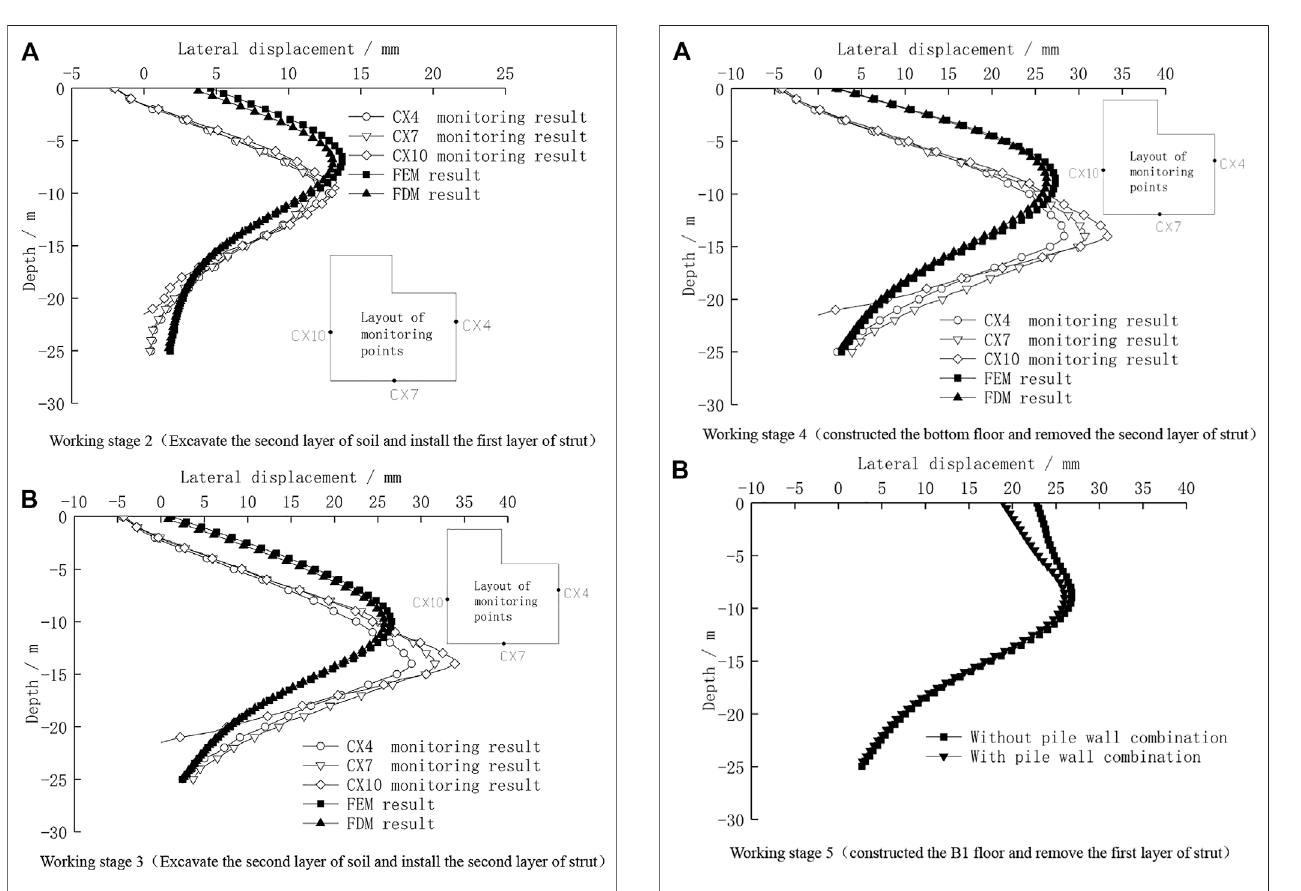
FIGURE 5 | Lateral displacement of retaining piles during the foundation pit excavation. (A) Working stage 2 (Excavating the second layer of soil and installing the fi rst layer of the strut). (B) Working stage 3 (Excavating the second layer of soil and installing the second layer of the strut).